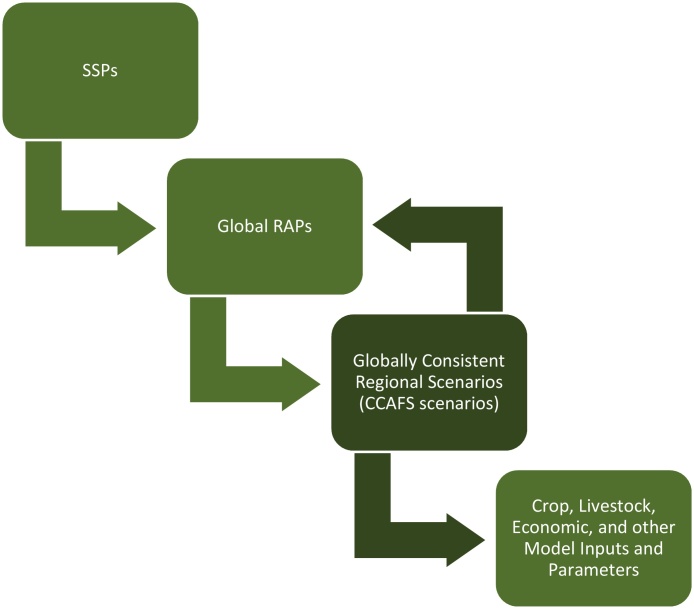
Globally consistent regional scenarios adapted from Valdivia et al. (2015).